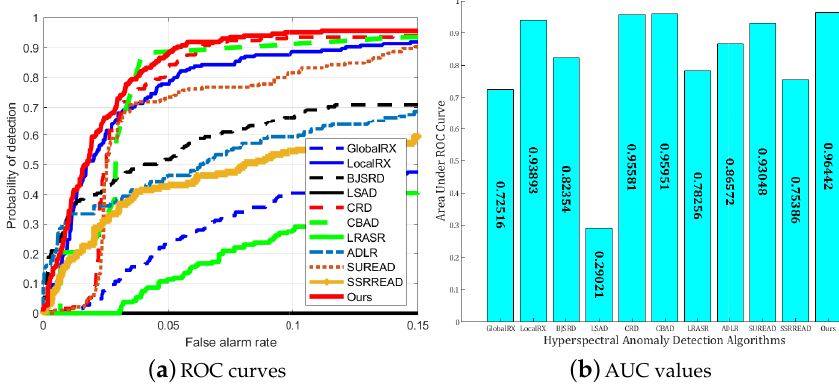
Figure 15. ROC curves and AUC values for the Sandiego60 dataset.